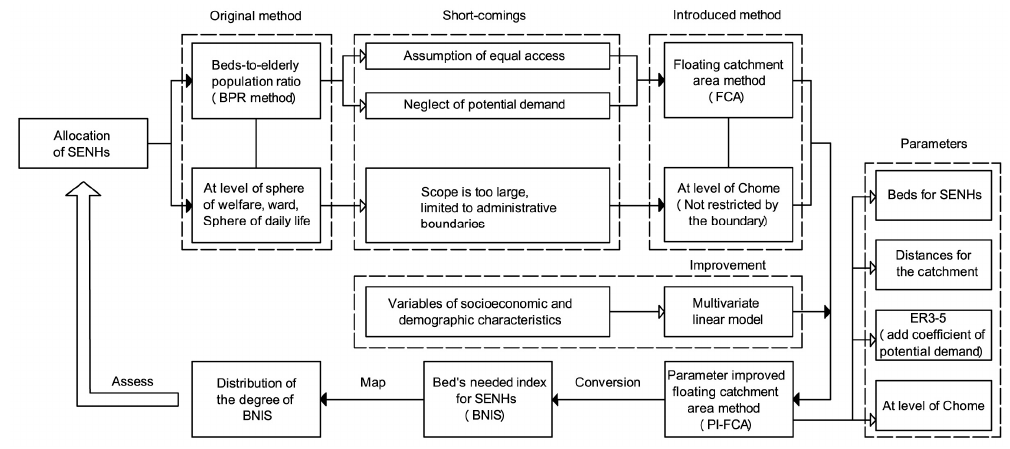
Figure 3. Framework chart.